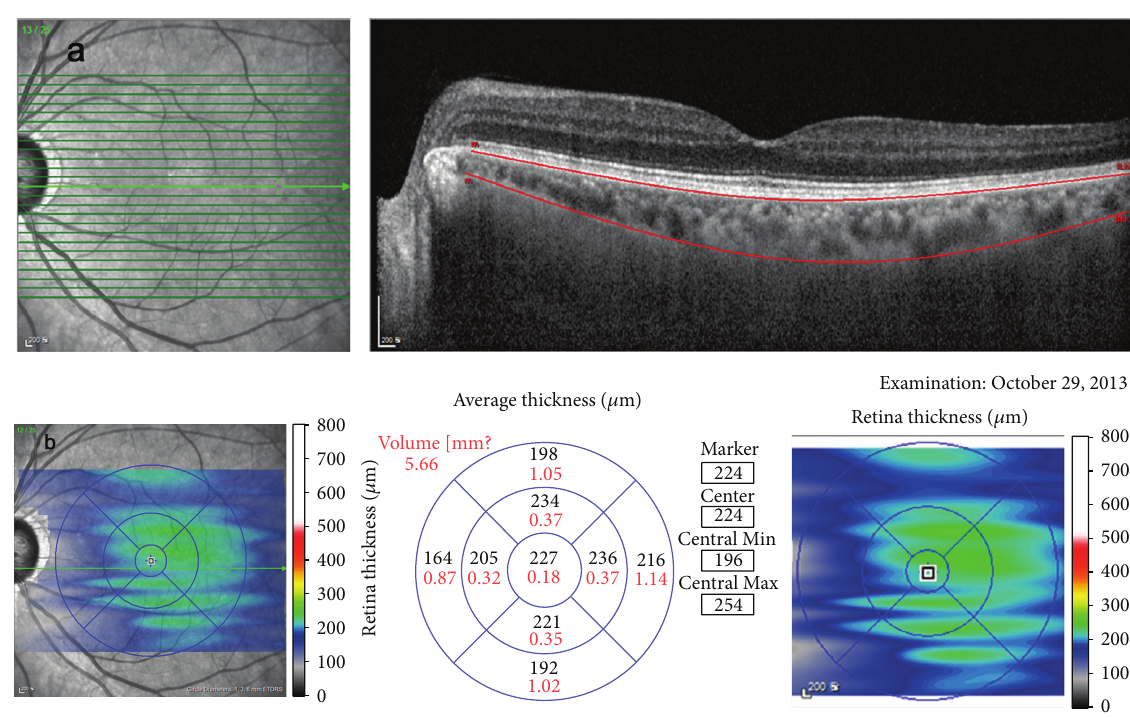
Figure 1: Choroidal volume measurement. For choroidal volume measurement, we manually moved the automatically segmented internal limitingmembranelinetotheretinalpigmentepitheliumandtheautomaticallysegmentedretinalpigmentepitheliumlinttothechorioscleral junction. Once we changed the automatically segmented line, the choroidal volume was automatically calculated and displayed within the ETDRS